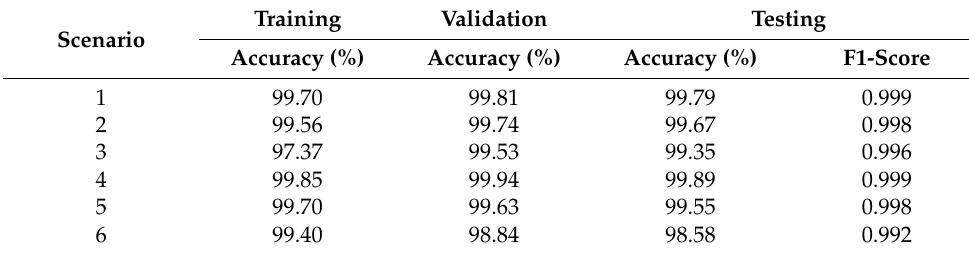
Table 5. Recapitulation of hyperparameter testing